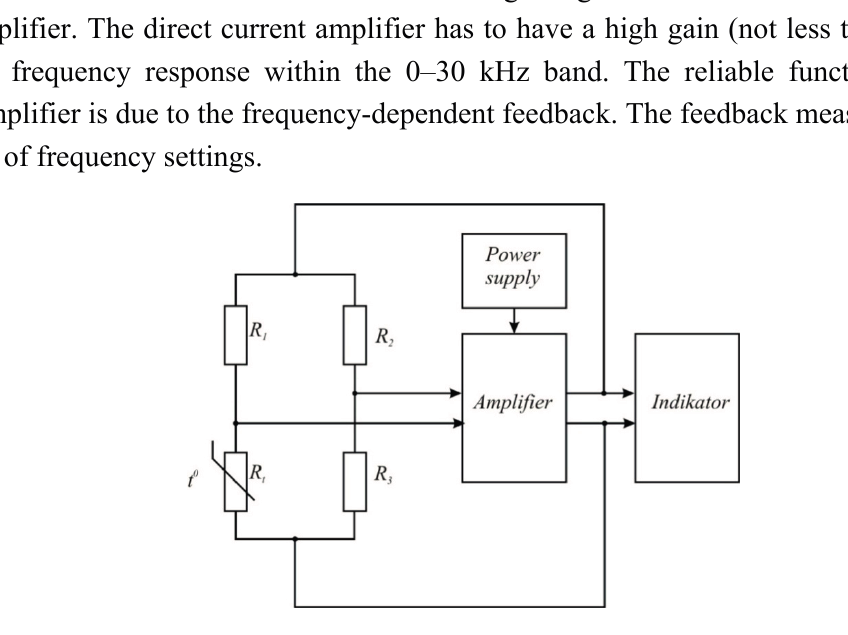
Figure 2. Thermo-anemometer of constant temperature type block diagram ( t 0 —the measured